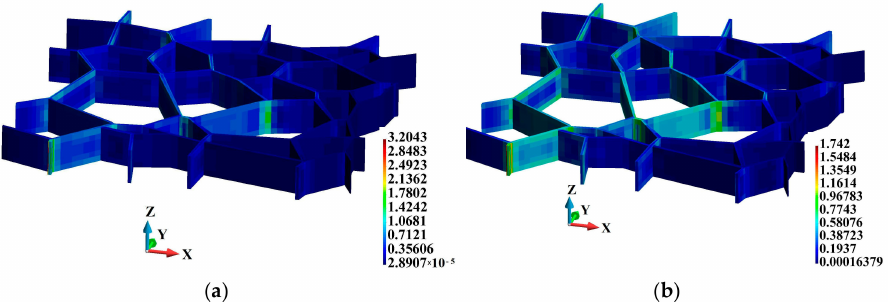
Figure 12. Equivalent plastic strain (non-dimensional) inside the binders: ( a ) Adiabatic solution; ( b ) coupled